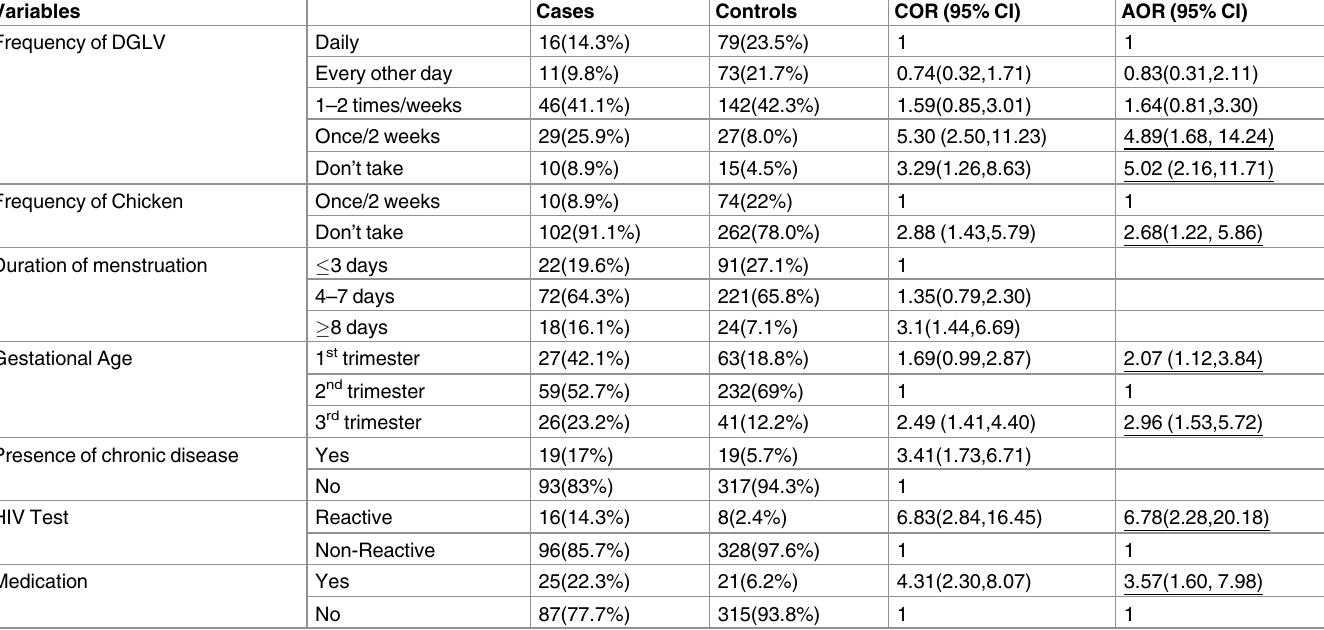
Table 2. Determinants of anemia among pregnant mothers attending ANC in health facilities of Dessie town, January to March 2016